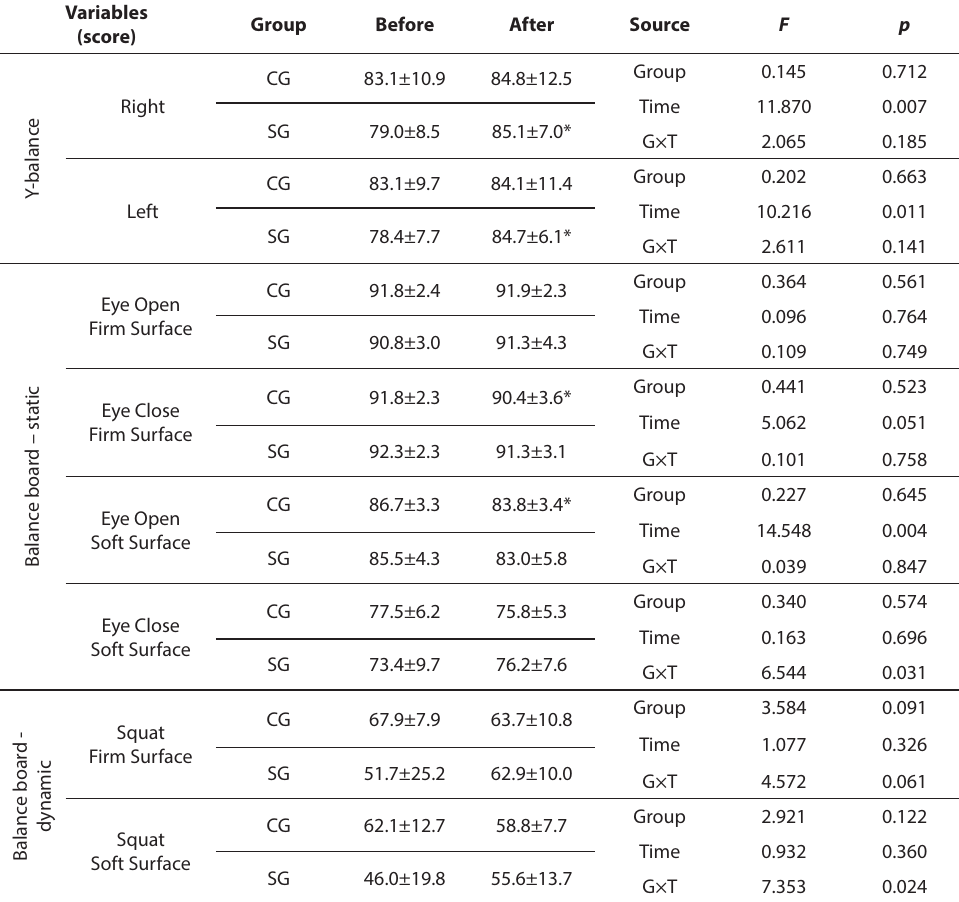
TABLE 3. Effects of a Four-week Core Stability Exercise on Balance